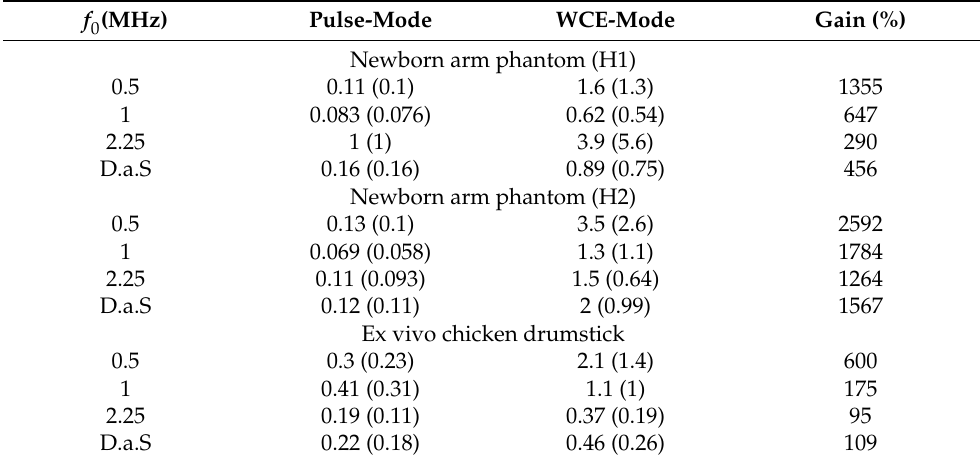
Table 6. Contrast-to-noise ratio (cid:104) CNR 0, r (cid:105) (average and standard deviation) and gain (%) between pulse-mode and WCE-mode methods for USCT of the newborn arm phantom (True Phantom Solutions), and of the ex vivo chicken